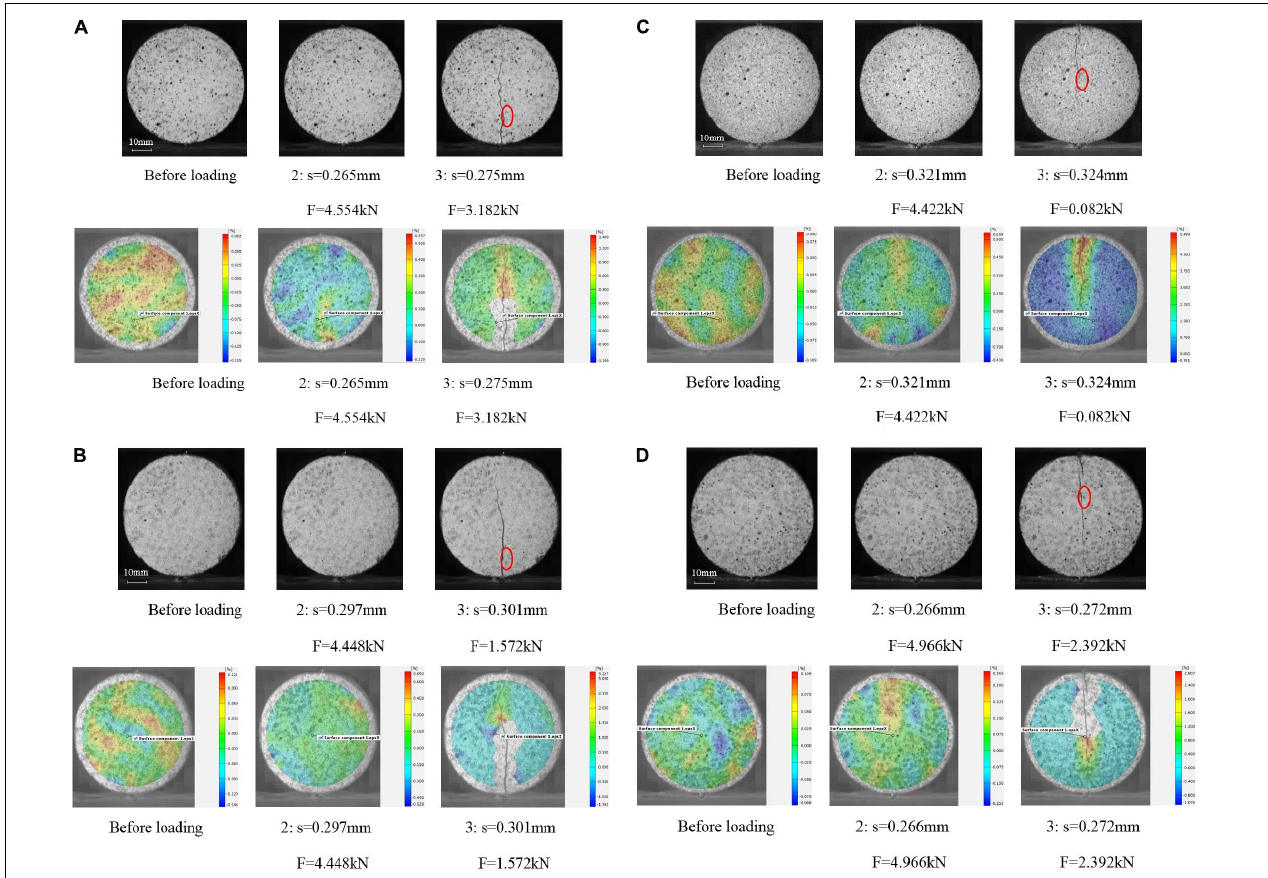
FIGURE 5 | Failure modes and evolution process of full strain field (Horizontal strain) on the surface of BD gritstone specimens in Ht group under static splitting tension (The Arabic numbers correspond to those in Figure 4A : (A) specimen 10M1; (B) specimen 30M1; (C) specimen 50M1; (D) original specimen. Red circle is the sampling position used in